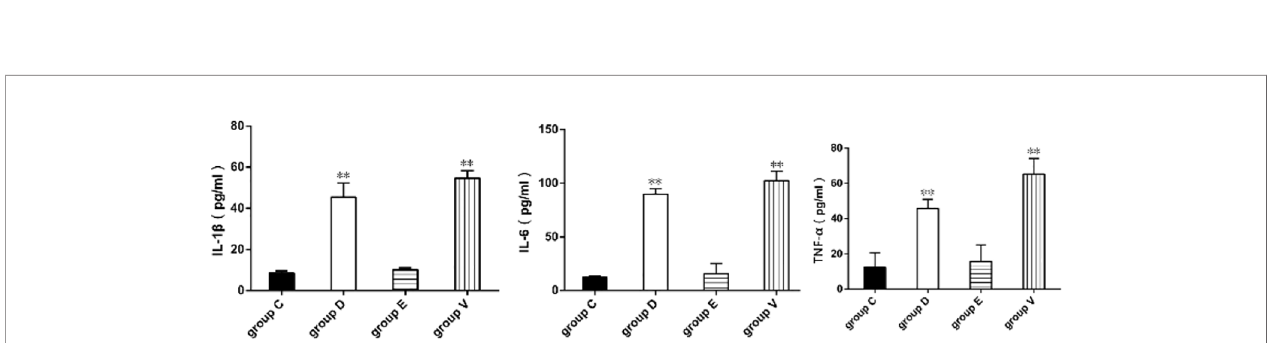
FIGURE 3 | Determination of proin fl ammatory factors. **represented signi fi cant difference ( P < 0.01). Statistical signi fi cance was evaluated by one-way analysis of variance (ANOVA) followed by Tukey ’ s multiple comparison